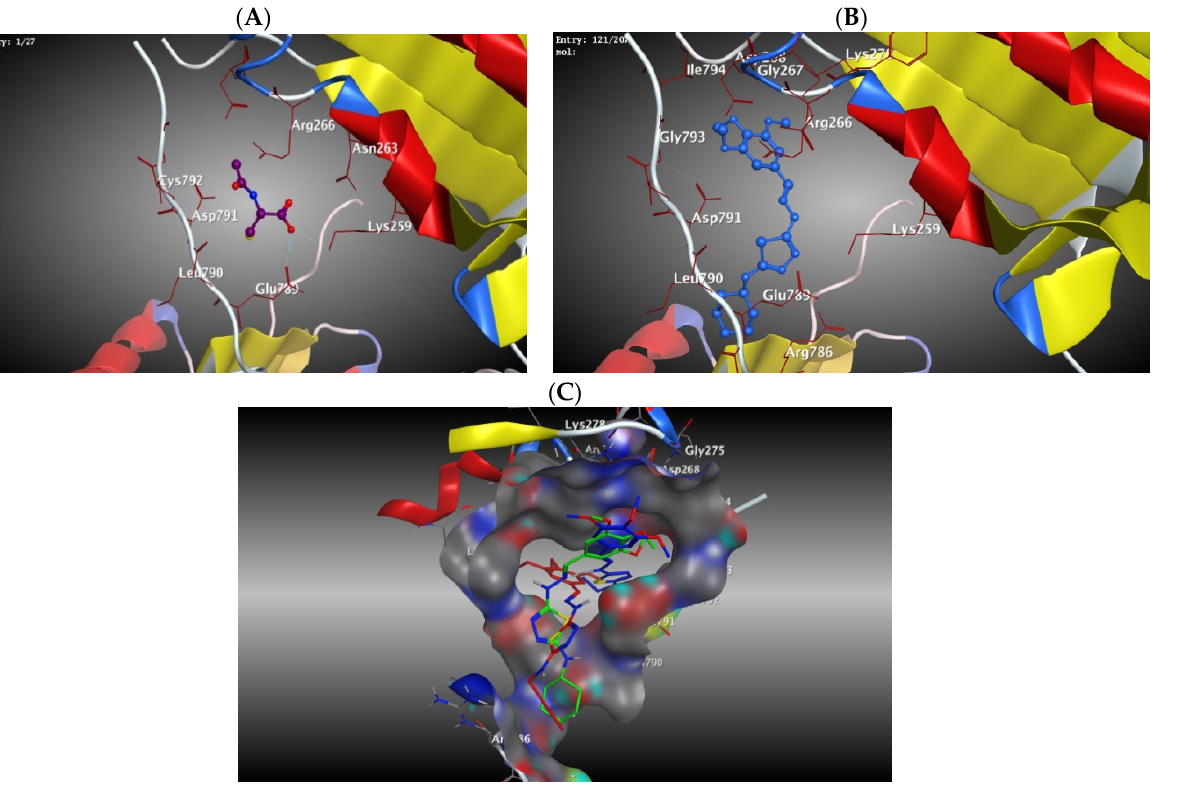
Figure 15. Three-dimensional representation of docking and ligand interactions of ( A ); NAC, ( B ); compound 2c , ( C ); superimposition of the active docked poses of 2a (red) aligned with 2c (blue) and 2e (green) inside the caspase-3 active site (PDB code: 1RHJ).